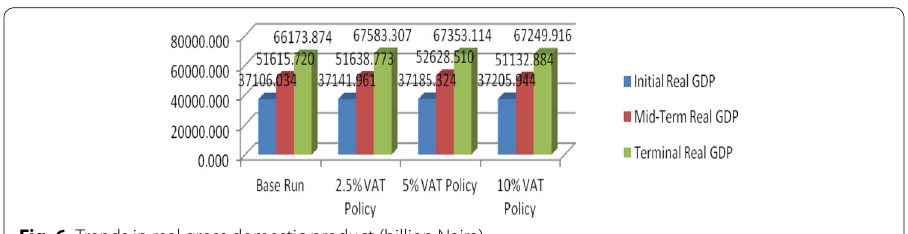
Fig. 6 Trends in real gross domestic product (billion